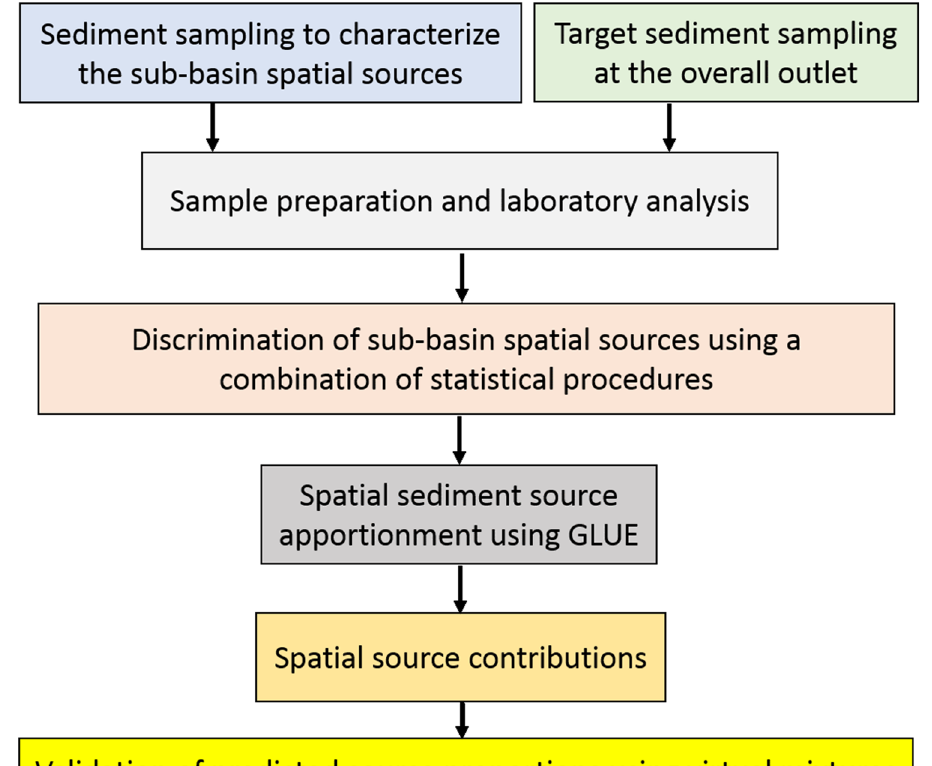
Figure 4. Flowchart for the GLUE methodology applied for source fingerprinting of the target sediment samples collected from the Mehran River.